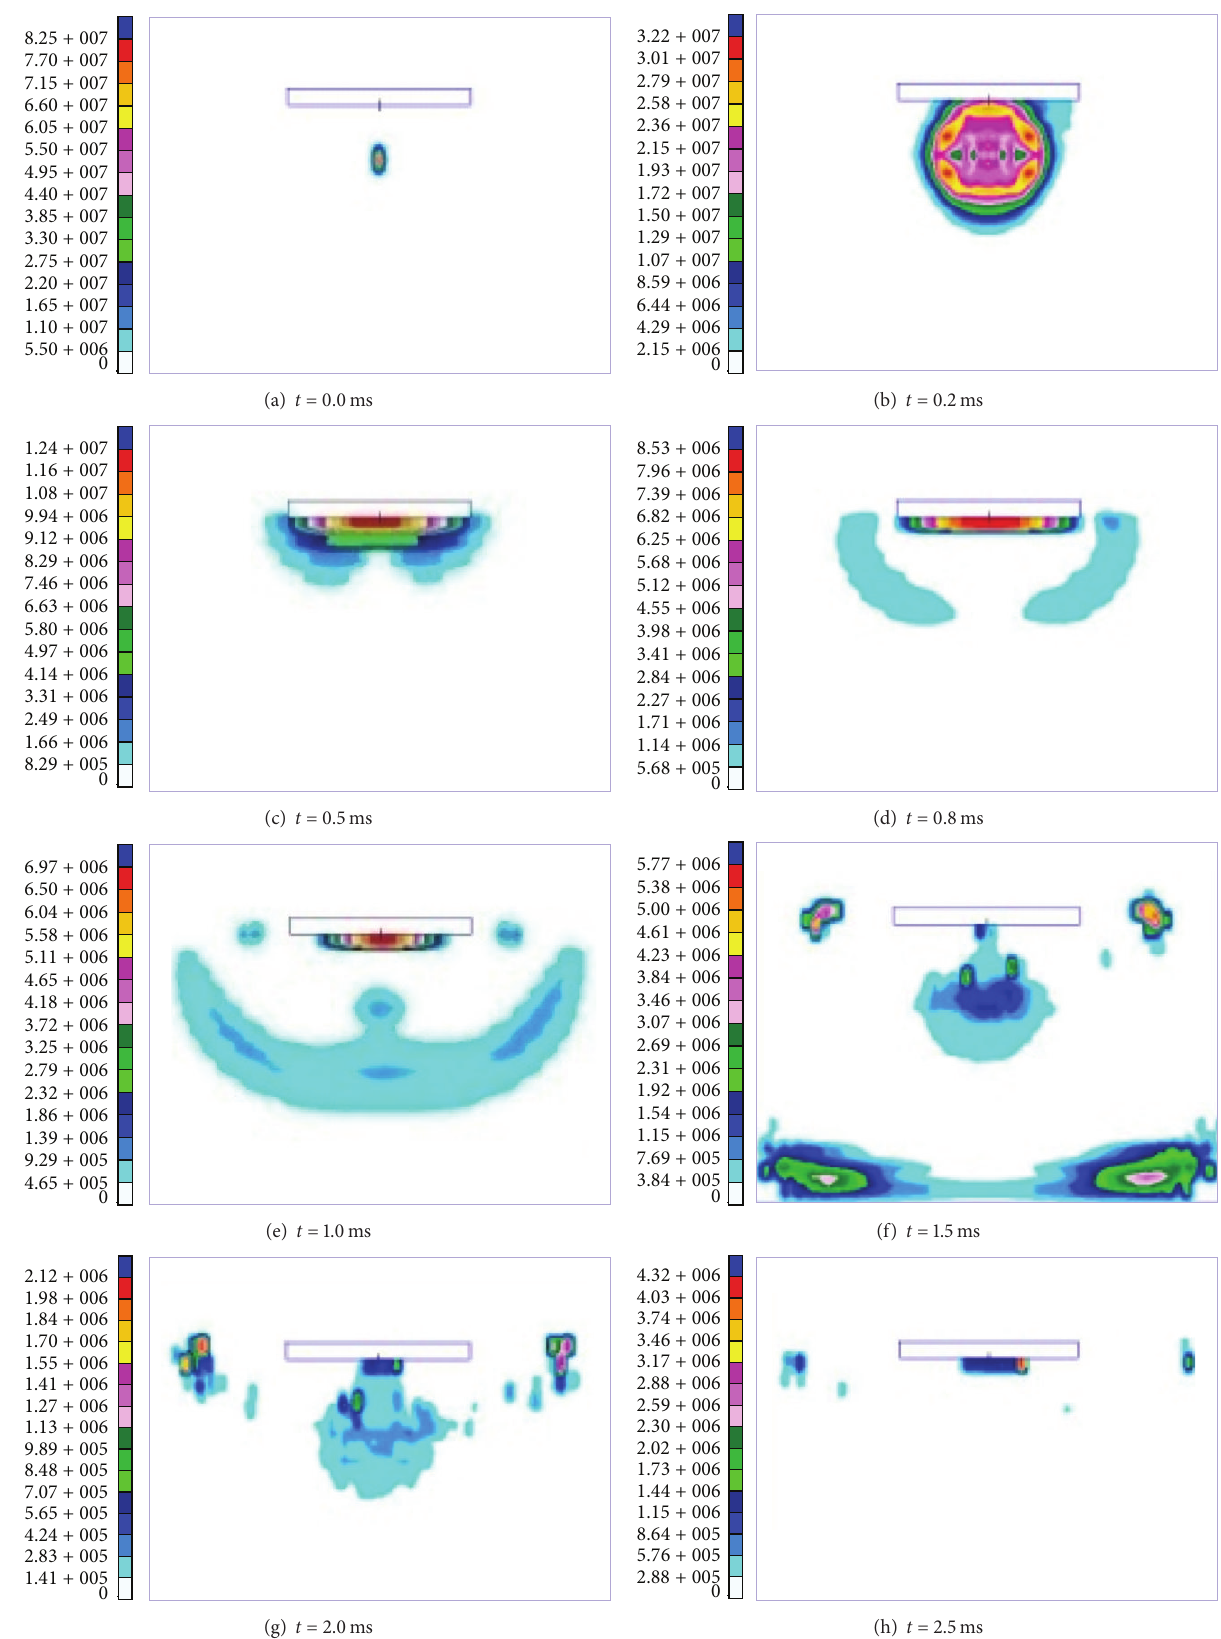
Figure 13: Bubble impact pressure contour ( W = 0.05 kg, d = 0.3